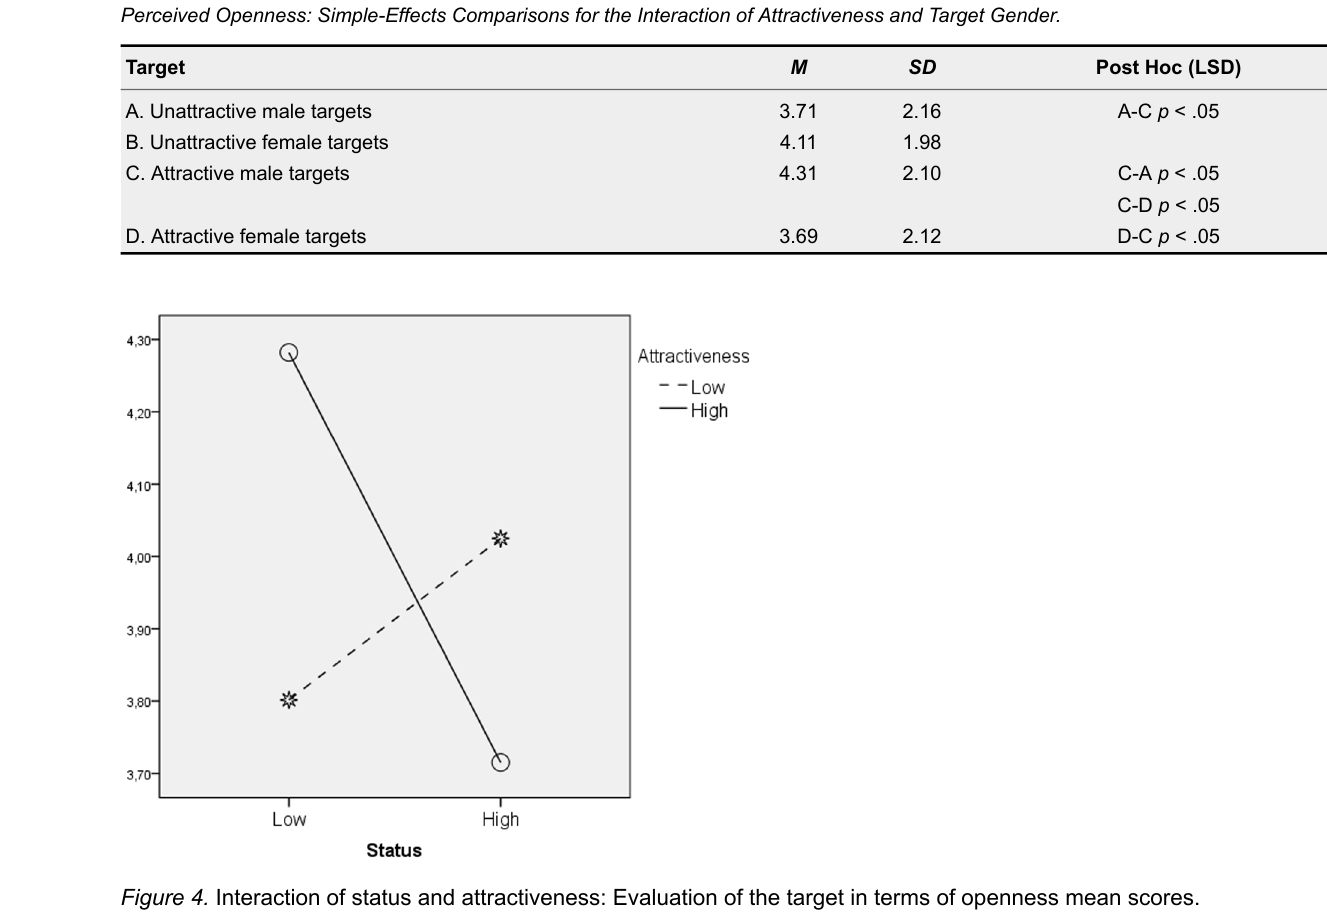
Europe's Journal of Psychology 2015, Vol. 11(4), 677–690